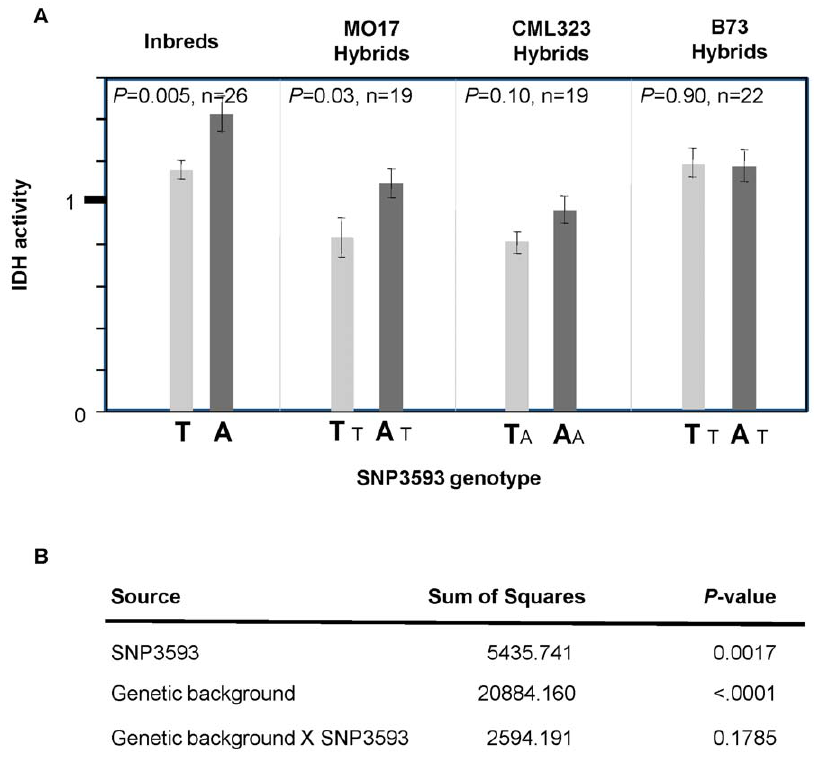
Figure 3. idh SNP3593 effect across different genetic backgrounds. ( A ) One-way analysis for idh SNP3593 effect at four different genetic backgrounds (inbreds, B73 hybrids, CML323 hybrids and Mo17 hybrids). Bolded letters below each bar represent the allele of the inbred parents. Smaller fonts T and A nucleotides indicate the donated tester allele. IDH activity is presented as standardized values. ( B ) Two-way ANOVA for SNP3593 effect, genetic background effect and the SNP by genetic background interaction.